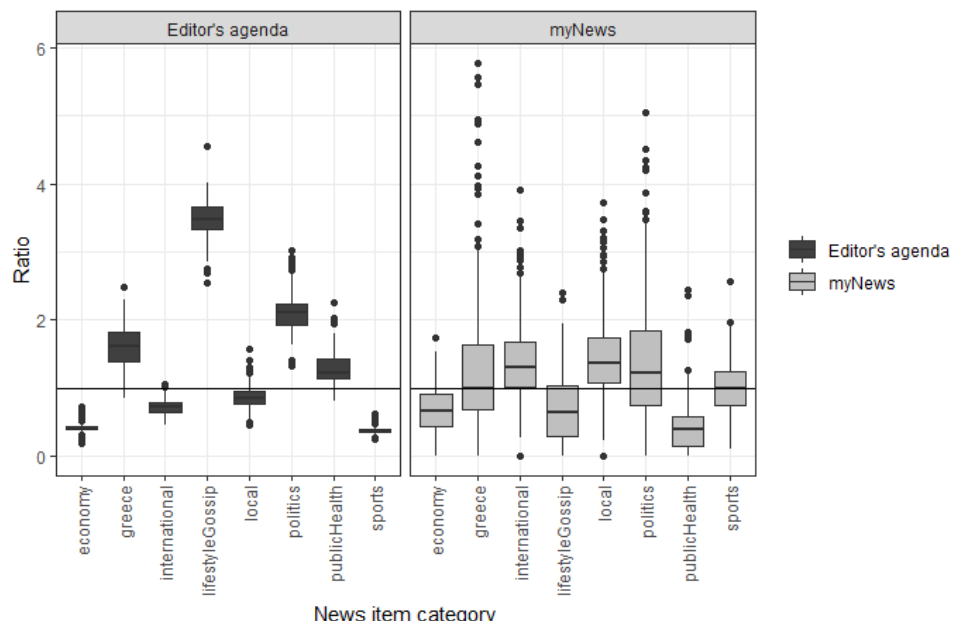
Figure 7. Boxplots of ratios of the Editor’s Agenda and MyNews item categories to the available Pool items.